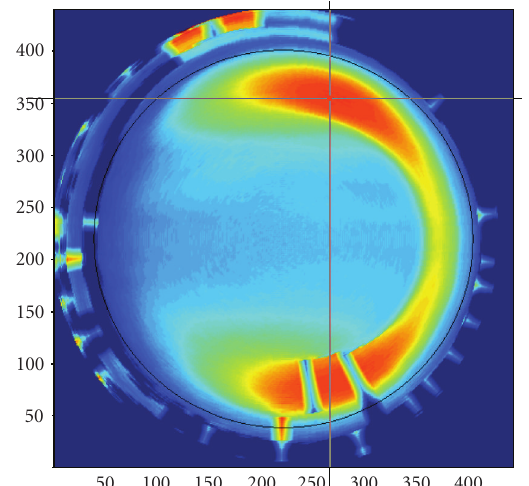
Figure 9: Selection of the useful area (black circle) and the point of minimum film thickness (cross point).